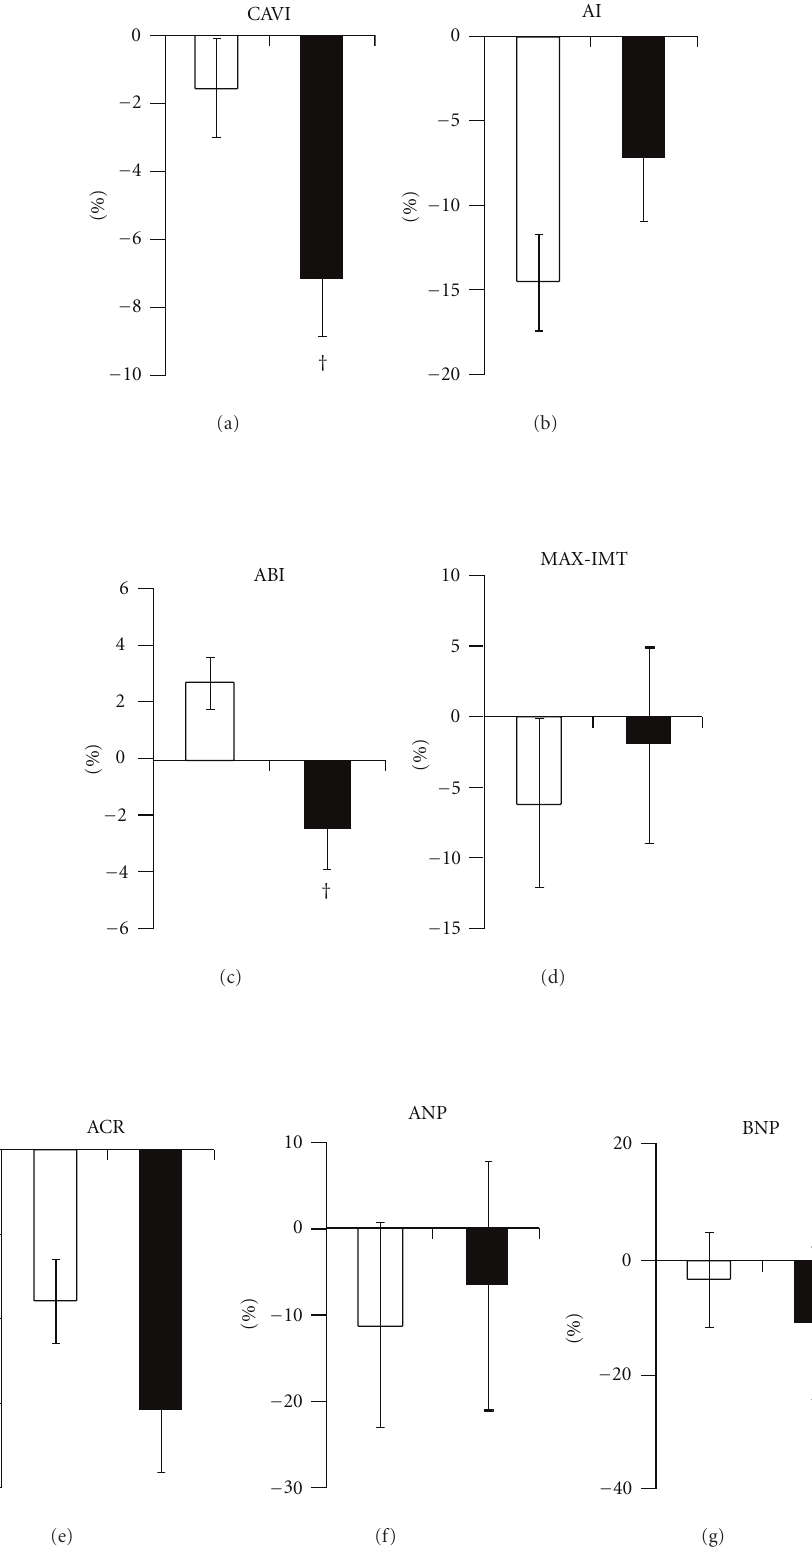
Figure 3: Changes from the baseline value for cardioankle vascular index (CAVI), augmentation index (AI), ankle-brachial index (ABI), maximum of intima-media thickness (MAX-IMT), urinary albumin to creatinine ratio (ACR), serum atrial natriuretic peptide (ANP), and serum brain natriuretic peptide (BNP) during 12 months of treatment with olmesartan monotherapy (open circles) or combination therapy with olmesartan and azelnidipine (closed circles). † P < . 05 versus the group treated with olmesartan